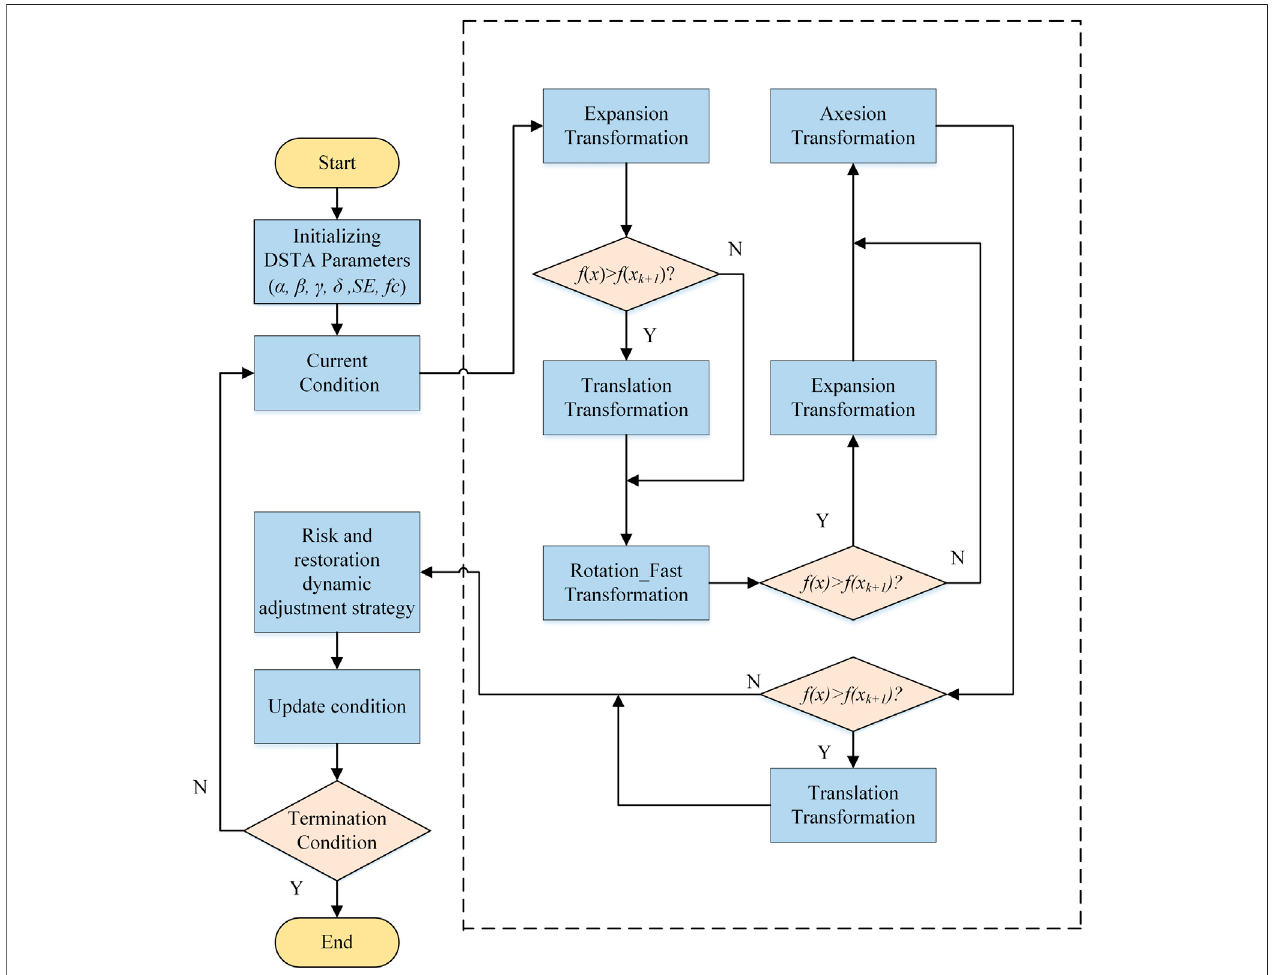
FIGURE 1 | Flowchart of dynamic state transition